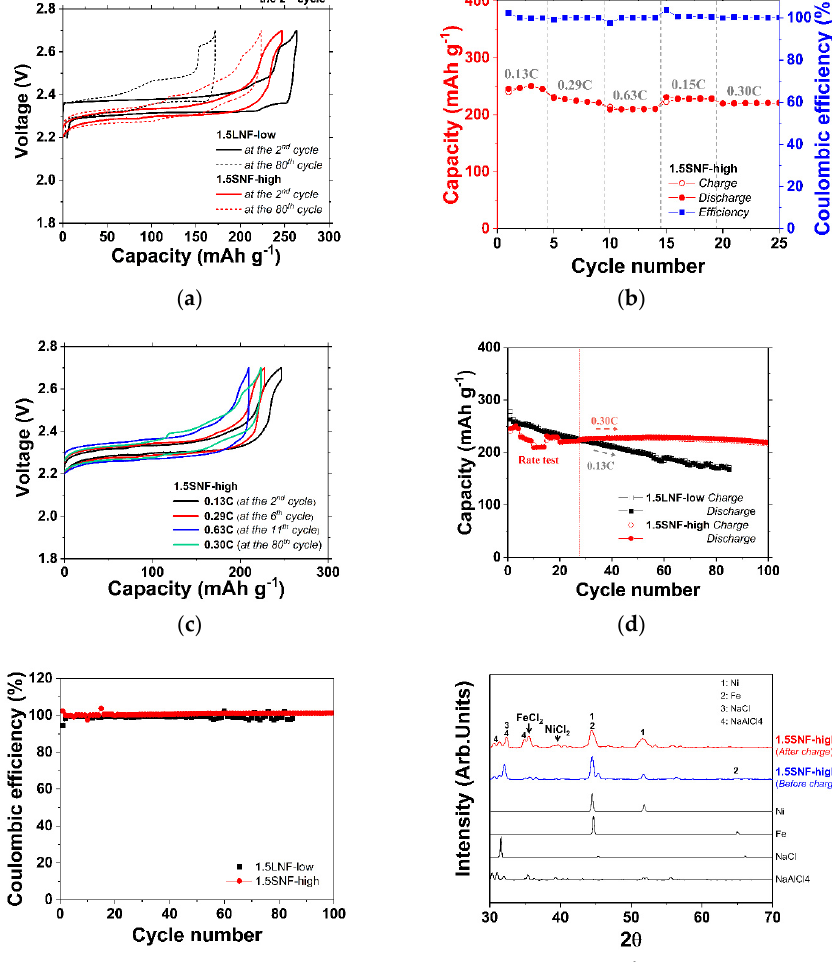
Figure 5. Electrochemical properties of 1.5LNF-low and 1.5SNF-high. ( a ) voltage profile; ( b ) rate capability of 1.5SNF-high cell; ( c ) voltage profile according to C-rate; ( d ) cycle performance for 100 cycles; ( e ) Coulombic efficiency; ( f ) X-ray diffraction (XRD) spectra.